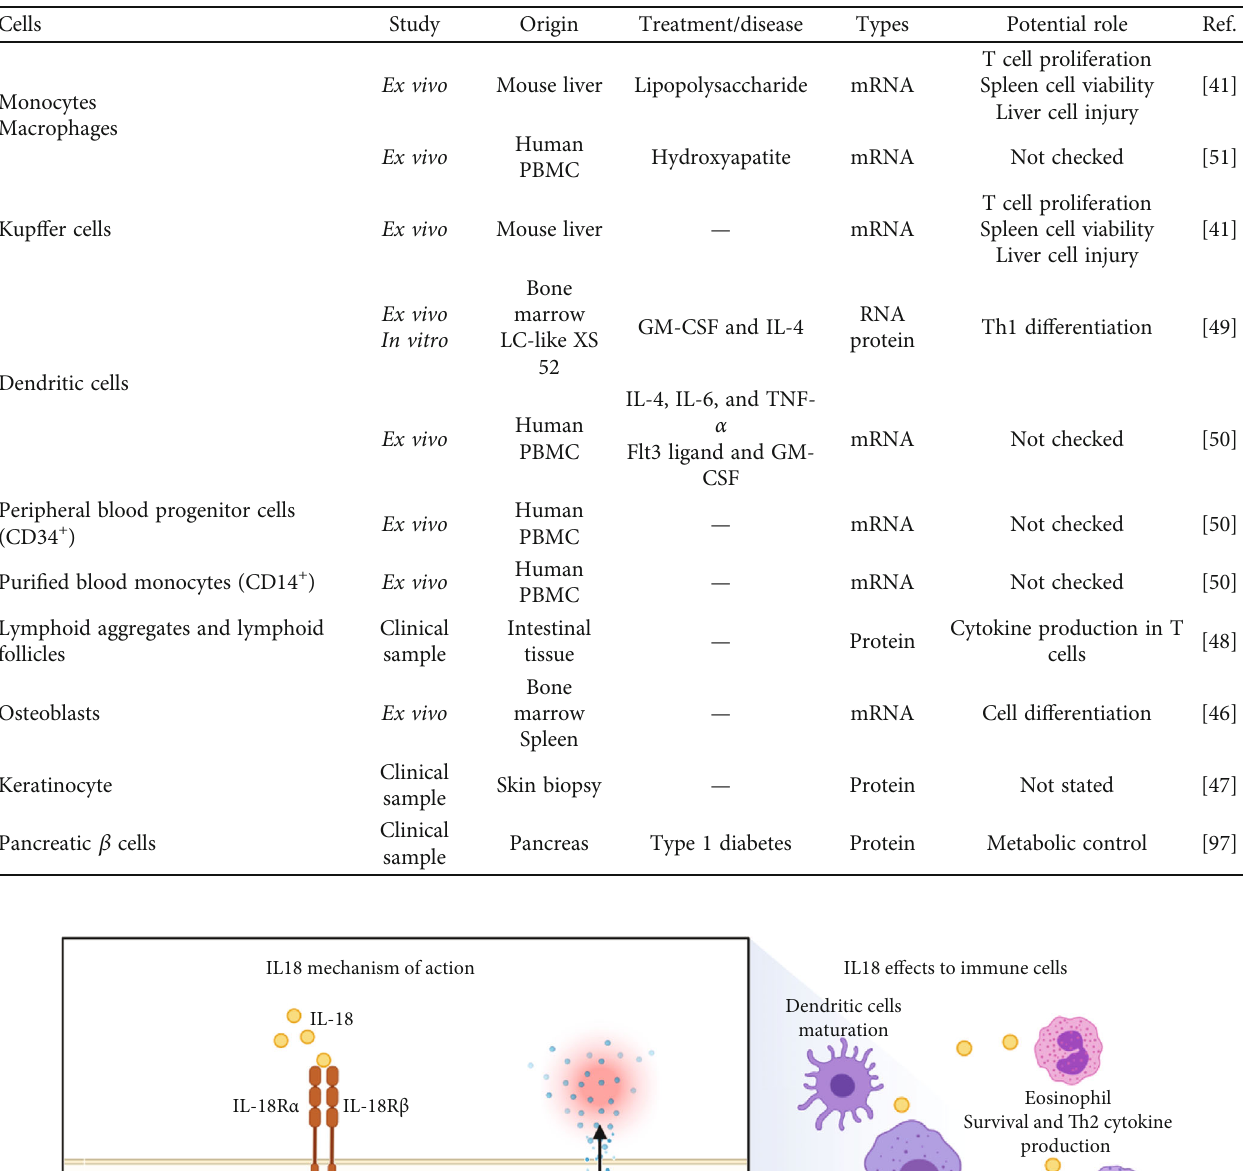
Table 1: IL-18 producing cells and the e ff ects after production.